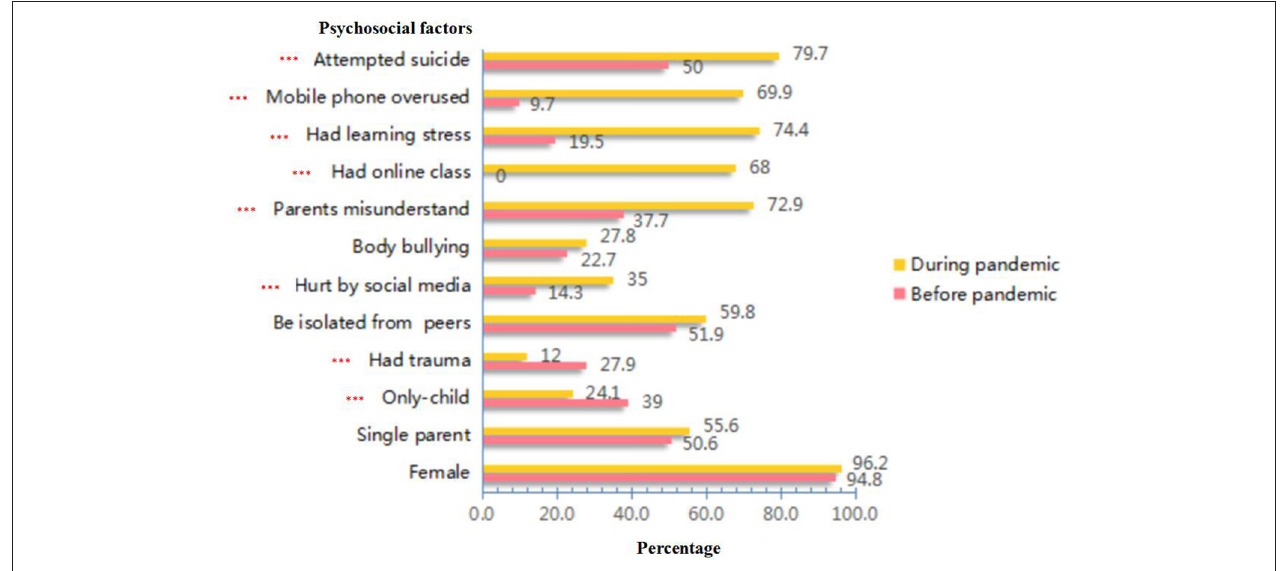
FIGURE 2 | The comparison of incidence rates of related psychosocial factors among NSSI adolescents in different periods. ***stands for P < 0.001.